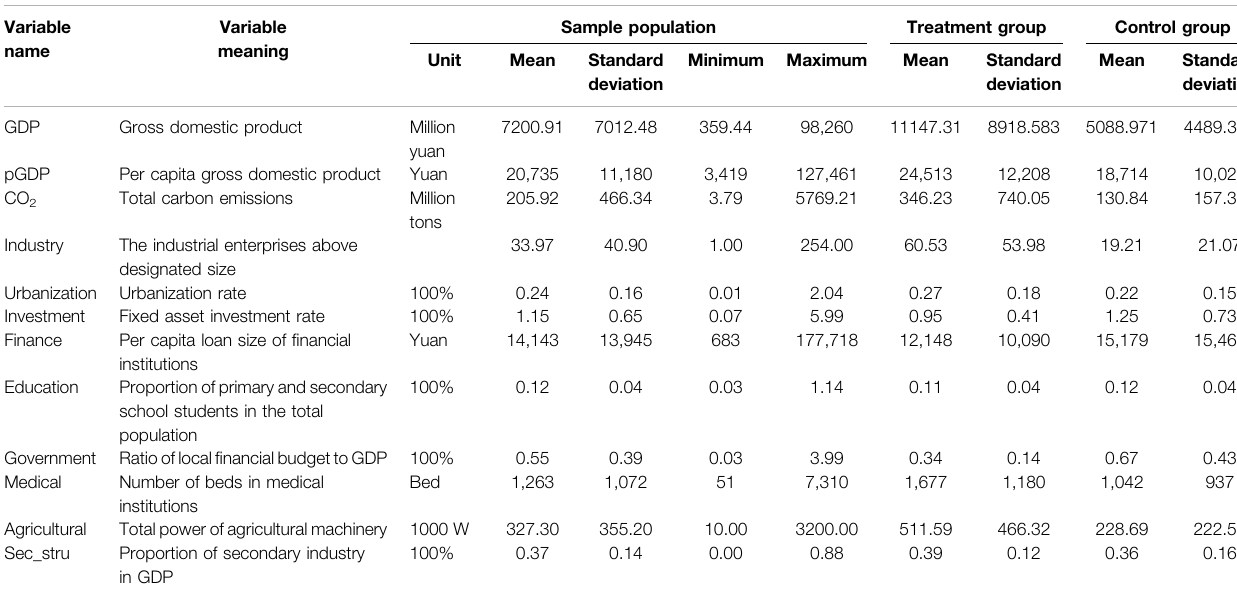
TABLE 2 | Descriptive